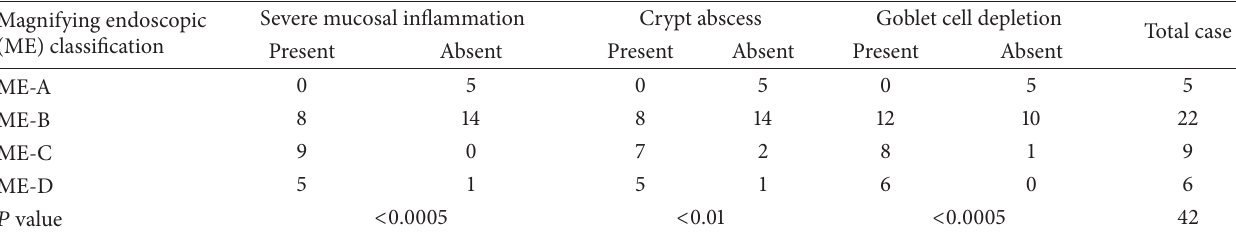
Table 3: Magnifying endoscopic (ME) classifications following crystal violet staining and pathognomonic histological features of ulcerative colitis.